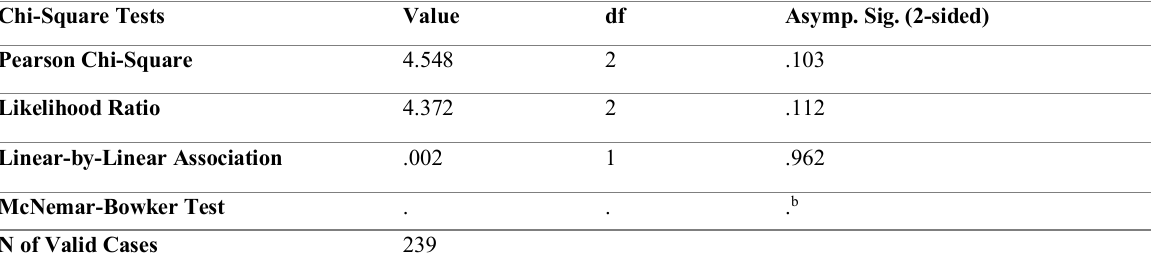
Table 2: Chi-square tests on copayment against type of